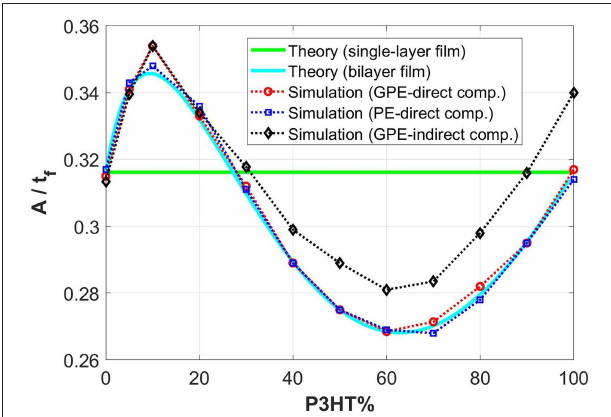
FIGURE 9 | Variations of simulated amplitudes (normalized by the total film thickness) with the fractional volume percentage of P3HT:PCBM layer, for the cases of generalized plane strain (GPE) under direct compression, plane strain (PE) under direct compression, and generalized plane strain (GPE) under indirect compression. Note that the numerical results pertain to e e all cases. The theoretical values (both single-layer and bilayer theories) are also included for